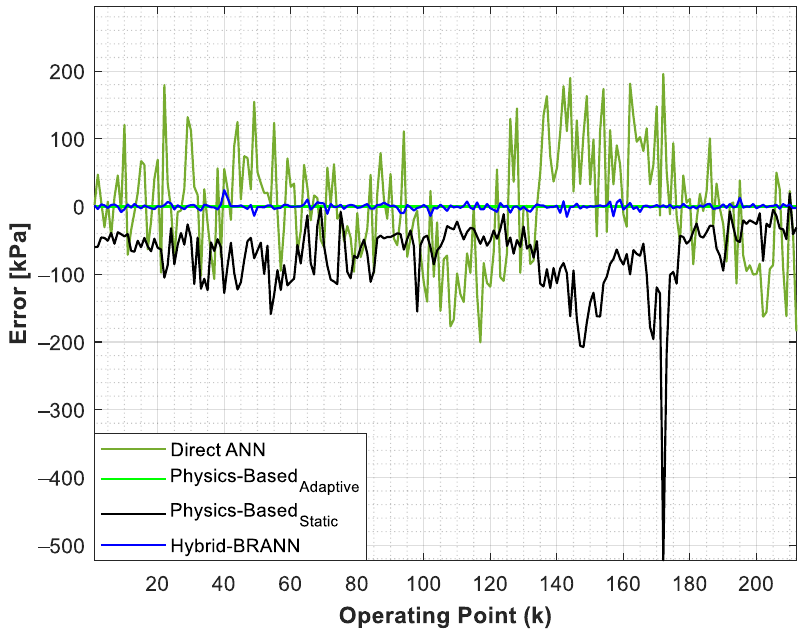
Figure 23. Comparison of IMEP model errors in a stochastic environment.